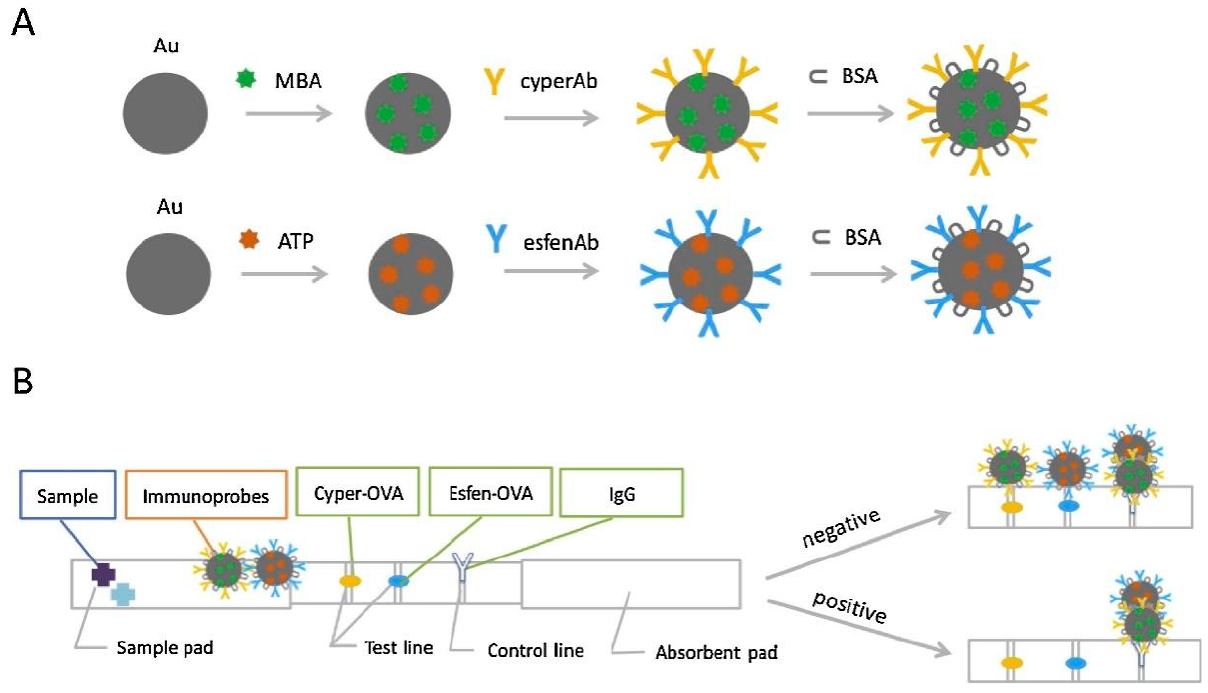
Figure 10. ( A ) Schematic illustration showing the preparation of two types of immunoprobes Au- MBA-cyperAb and Au-ATP-esfenAb; and ( B ) assembly of the ICA-SERS strip and schematic dia- gram of the mechanism for multiplex detection ([36]).